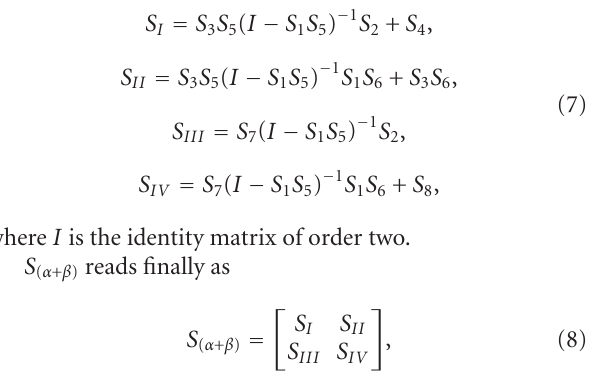
rings, coupling factors, etc.) over searching intervals suitably defined as a function of geometry and materials of the structure, it is possible to find a minimum value for the error ε ; this minimum corresponds to the best set of parameters for the given PSE.